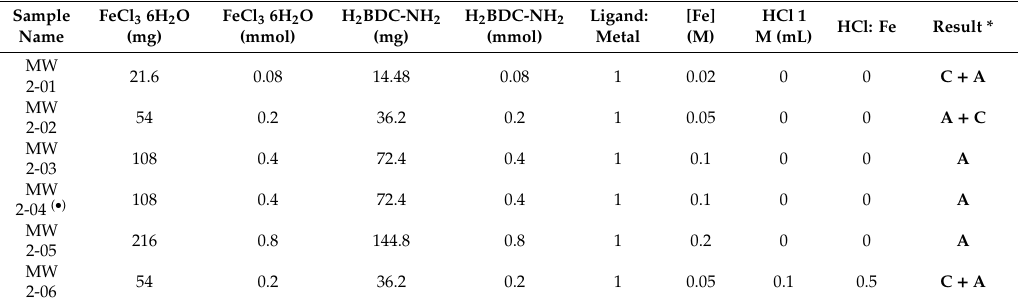
Table 1. Mass, mol and molar ratios, and dispensed amounts for the MW investigation of the system